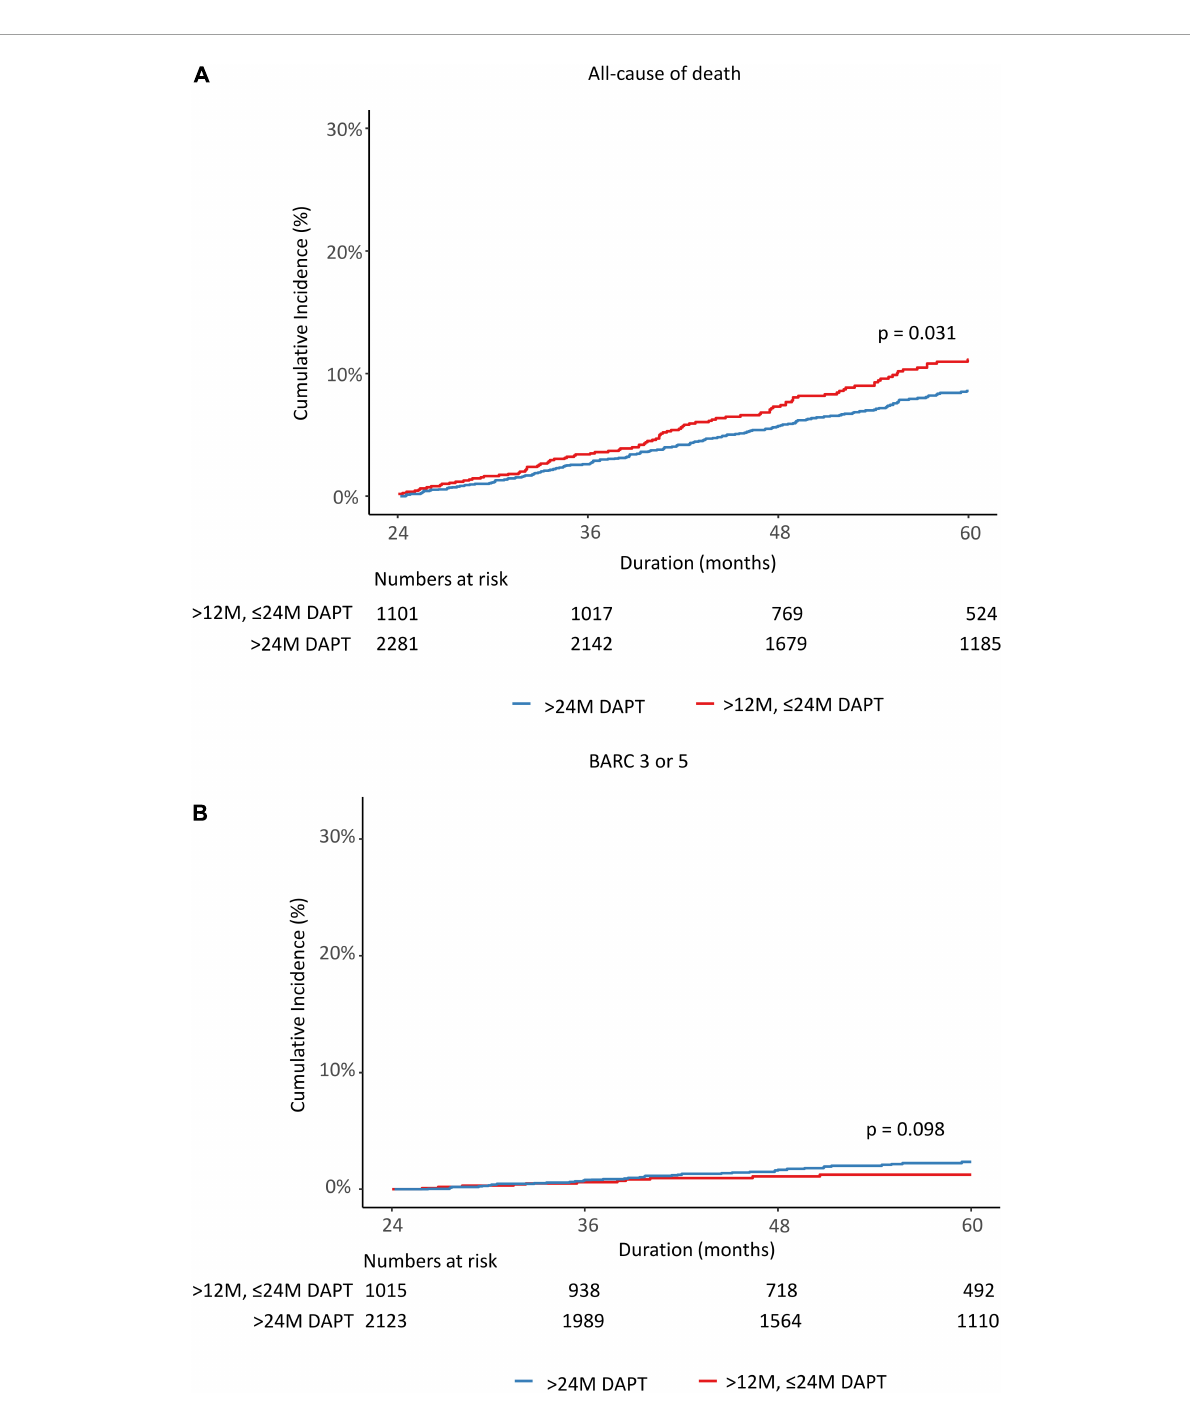
FIGURE4 Rates of all causes of death (A) and major bleeding (B) from 24 to 60 months after the index percutaneous coronary intervention. DAPT, dual antiplatelet therapy; BARC, bleeding academic research consortium.